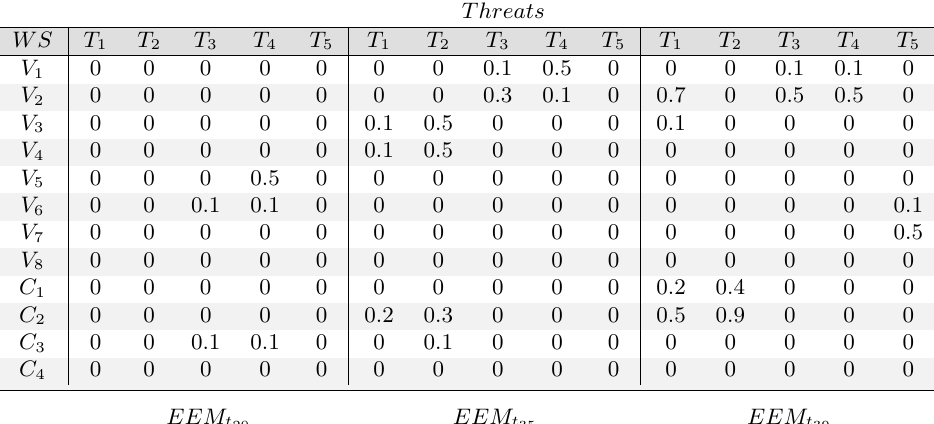
Table 4: The EEMs for stages t